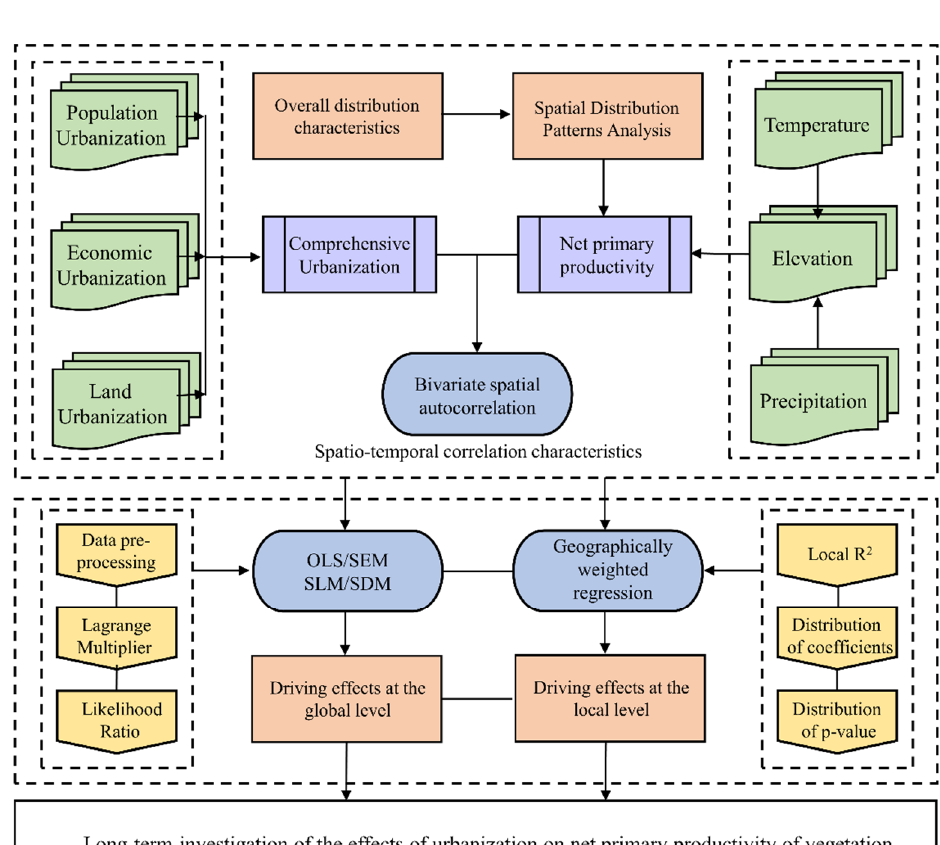
Figure 2. Technical route of this research.